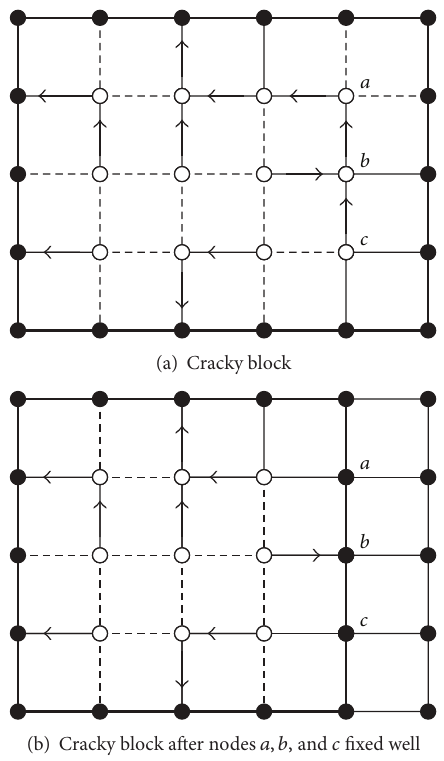
Figure 5: A sample of self-adaptive block.